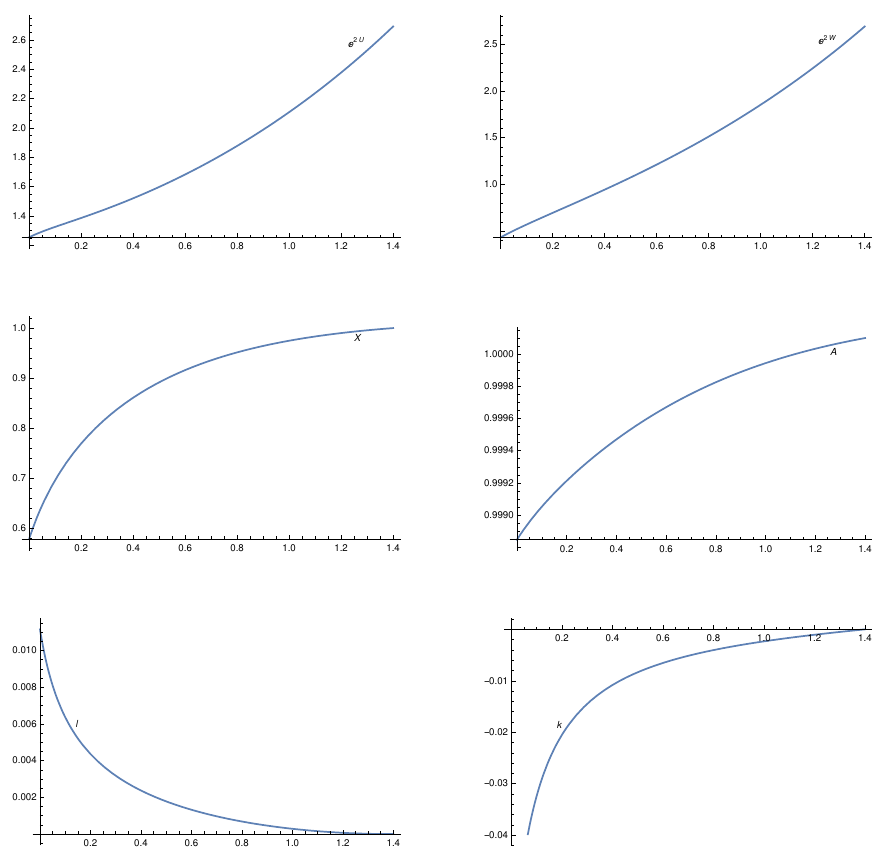
Figure 1 . Flows of e 2 U ( r ) ; e 2 W ( r ) ; X ( r ) ; A ( r ) ; l ( r ) ; k ( r ) plotted in the interval r 2 (0 ; 1 : 4] with g = 1, h = 1 , (cid:20) = 1 and V ( r ) = p 2 2